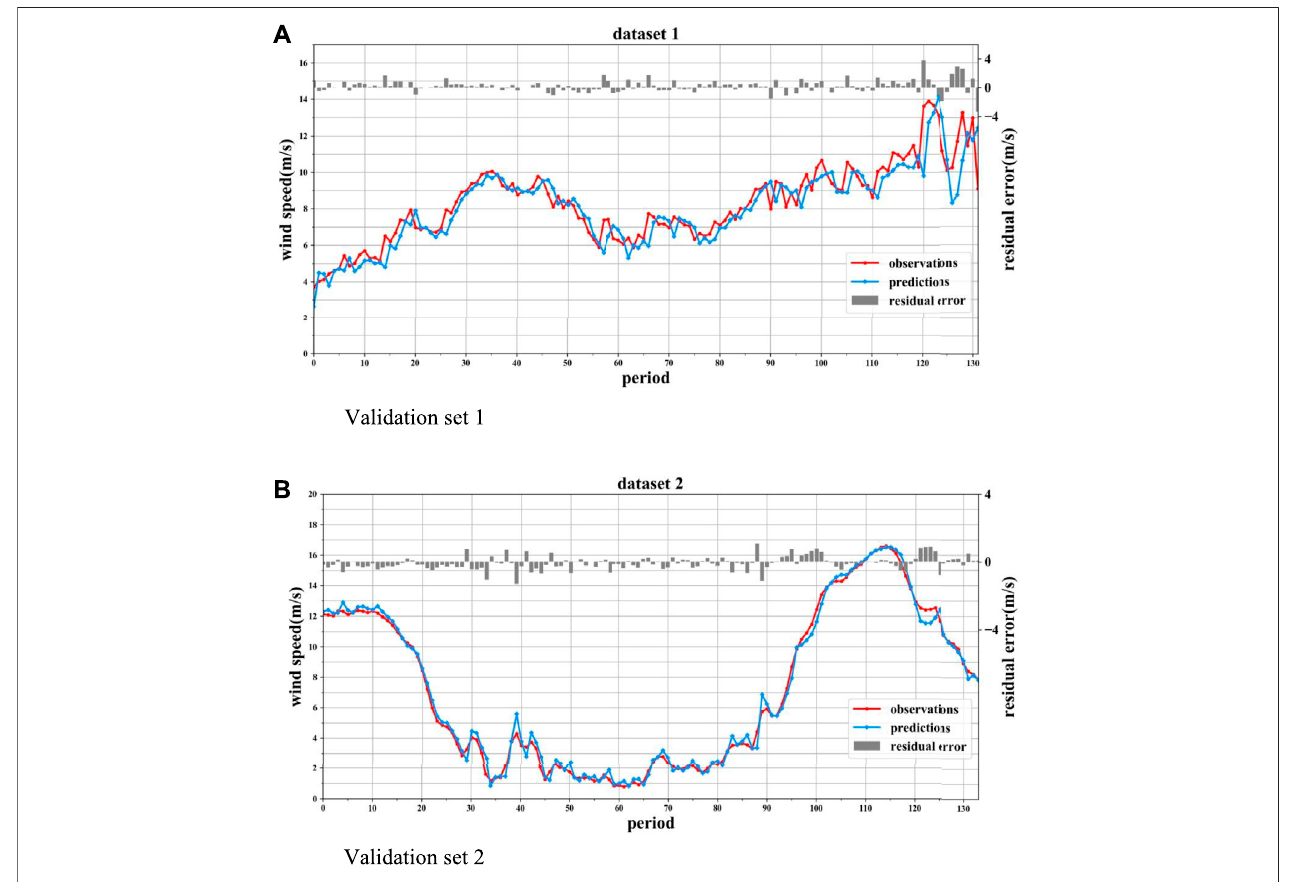
FIGURE 4 | Wind speed prediction results for validation sets 1 and 2. (A) Validation set 1. (B) Validation set 2.